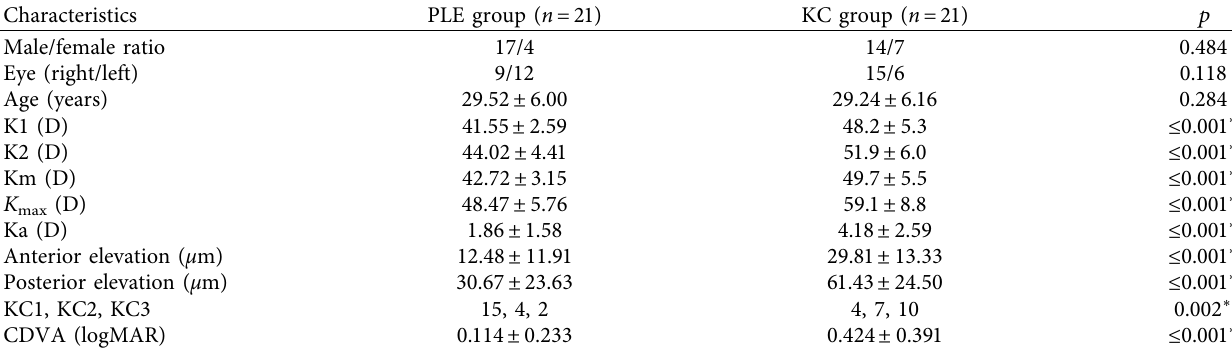
Table 1: Demographic and topographic characteristics of the